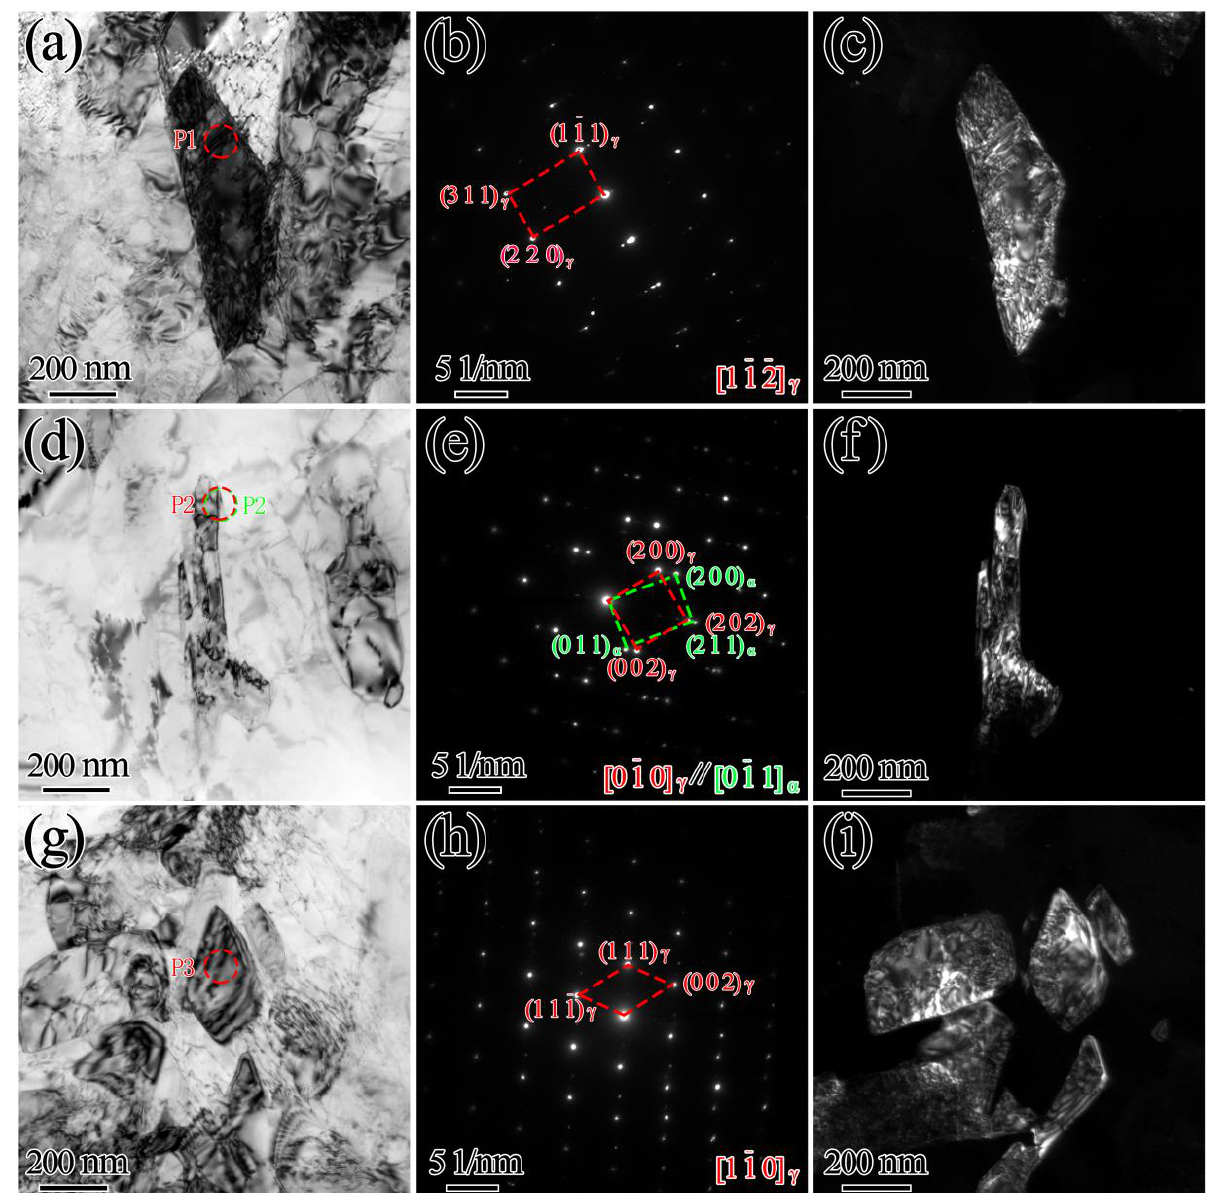
Figure 4. TEM images in double-step tempered samples: ( a – c ) 625 °C (3 h) + 600 °C (2 h); ( d – f ) 675 °C (3 h) + 600 °C (2 h); ( g – i ) 700 °C (3 h) + 600 °C (2 h); ( a,d,g ) bright-field images; ( b,e,h ) SAED patterns; ( c,f,i ) dark-field images.